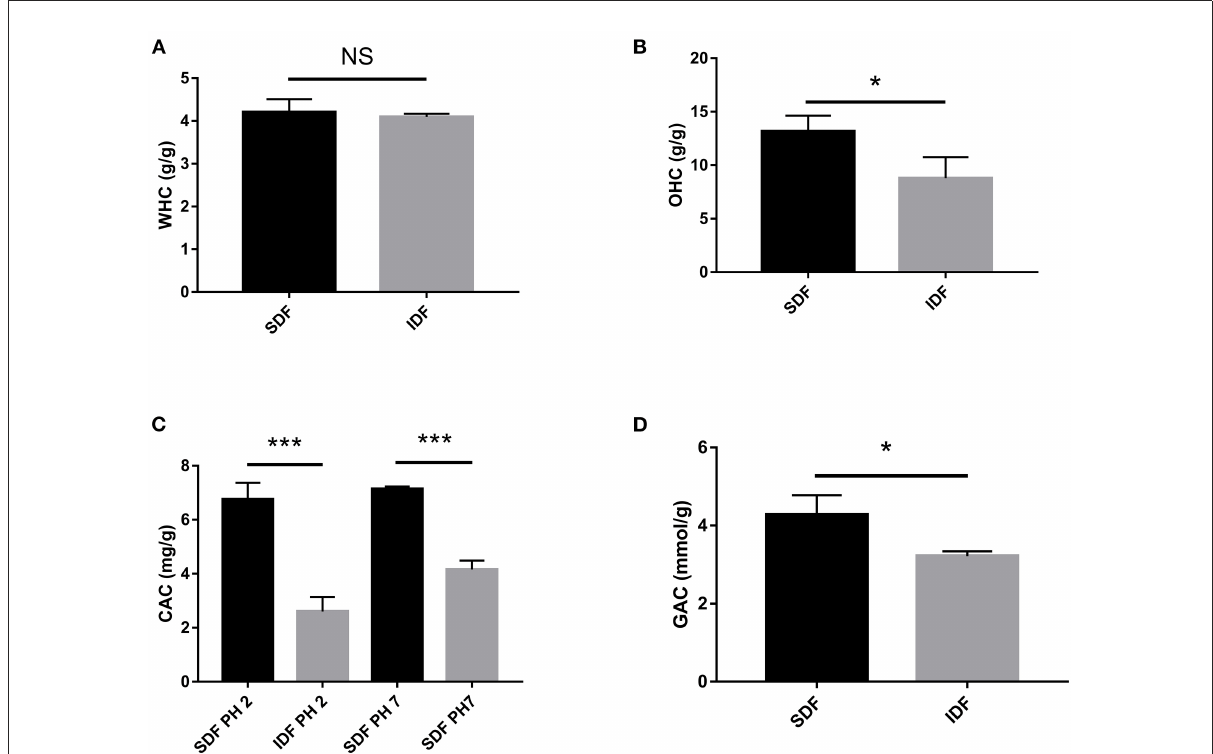
FIGURE3 In vitro effect of the WHC (A) , OHC (B) , CAC (C) , and GAC (D) of SDF and IDF. Each value represents the mean ± SD. The results were analyzed with the two-tailed Student’s t- test; * p < 0.05, *** p < 0.001, NS: non-significant.